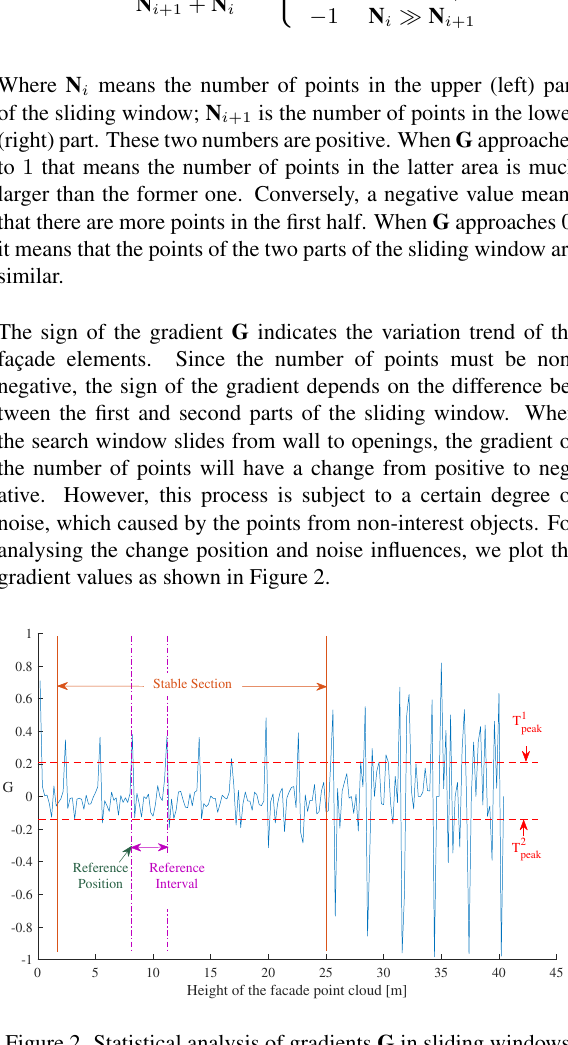
By the assumption, the peaks of the gradient in the statistic figure generally represent the change between openings and wall. Such peak values can be extracted by two filters. T 1 restricts the peak positive values (e.g. a window to a slab) that values below this threshold will be filtered out. In contrast, the gradients staying over the constraint will be treated as peak values. Similarly, we keep values which are less than the T 2 constraint (e.g. a wall peak to an opening). Each change should perform a sharp rising or down trend following a regular